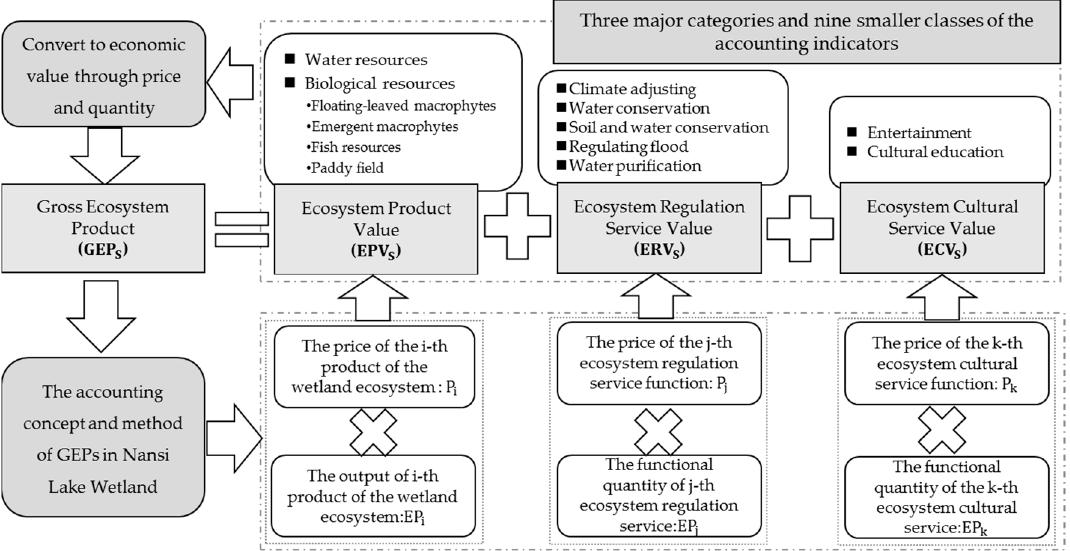
Figure 2. The accounting framework for the GEP of the Nansi Lake Wetland. Table 1. Accounting indicators and formulas for the gross ecosystem product in the Nansi Lake Wetland 1 .